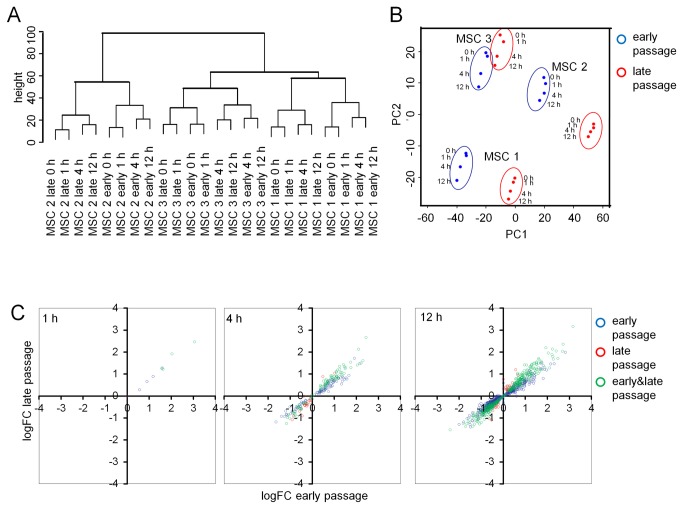
Gene expression changes upon TGF-β1 treatment in early and later passages.Hierarchical clustering of global gene expression profiles (Euclidean distance) revealed inter-donor variation, a close relationship of early and late passages, and continuous changes with TGF-β1 stimulation (A). This was also reflected by principal component analysis (B; components 1 [PC1] and 2 [PC2] are depicted). TGF-β1-induced gene expression changes were compared in MSCs of early passage (P3 - P5) and later passage (P10) upon stimulation for either 1, 4, or 12 hours. Some genes are predominantly induced in early passage (depicted in blue) or in late passage (depicted in red) but the induced gene expression changes were overall very similar in MSCs of early and later passage (C).